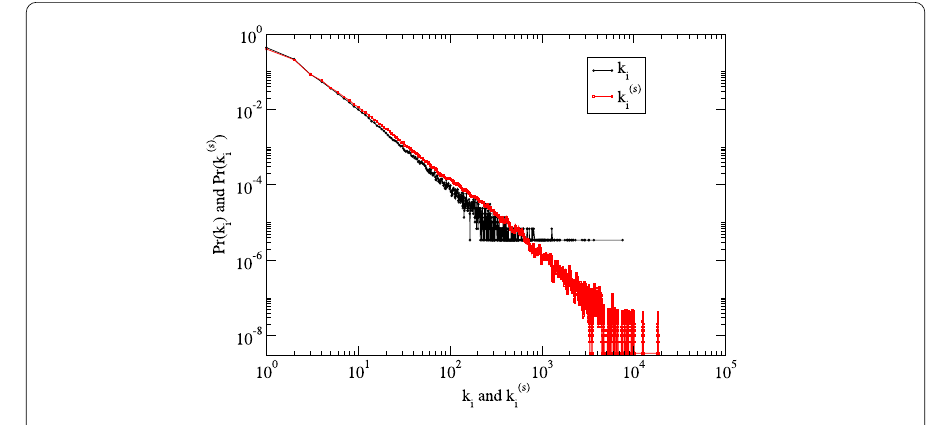
Figure 17 Distributions Pr( k i ) (black ‘ ◦ ’) and Pr( k ( s ) ) (red ‘ (cid:3) ’) for M = 10 3 Monte Carlo realizations. The i distributions are similar but Pr( k ( s ) i ) systematically deviates to become more skewed as k i , k ( s ) i increase, signaling that fixing the overall flow through a node and allowing the degree to emerge as a consequence of this leads to larger degree than in observation